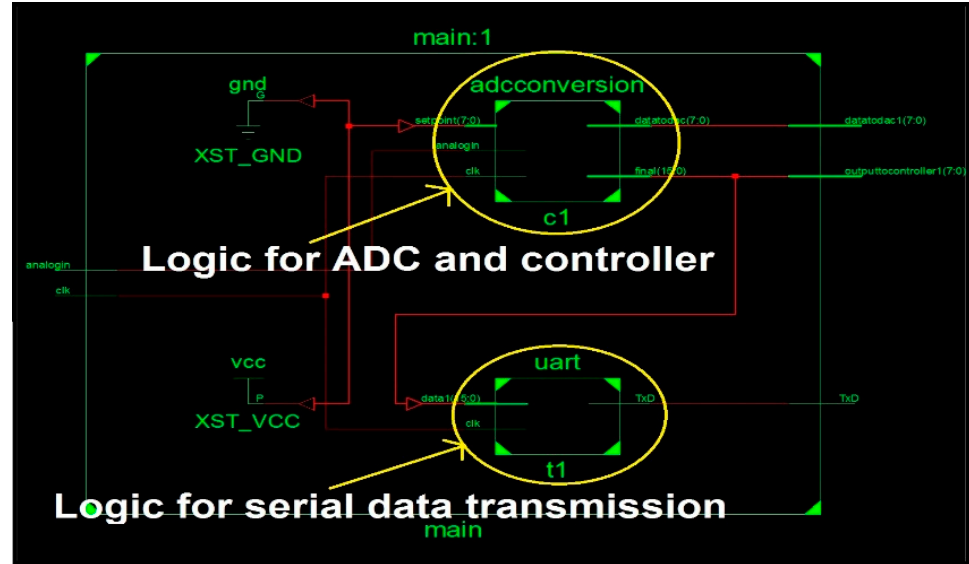
Figure 11. RTL Schematic for single closed-loop control system.